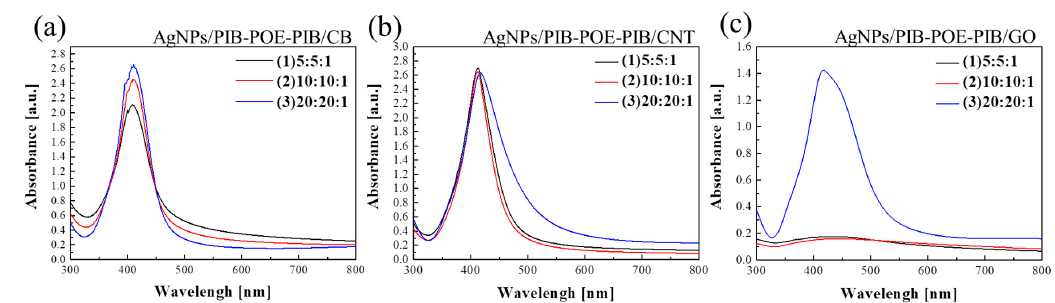
Figure 3. UV-vis absorption spectra of AgNPs/PIB-POE-PIB/carbon-based nanomaterial hybrids of different weight ratios. ( a ) AgNPs/PIB-POE-PIB/CB, ( b ) AgNPs/PIB-POE-PIB/CNT, and ( c ) AgNPs/PIB-POE-PIB/GO.